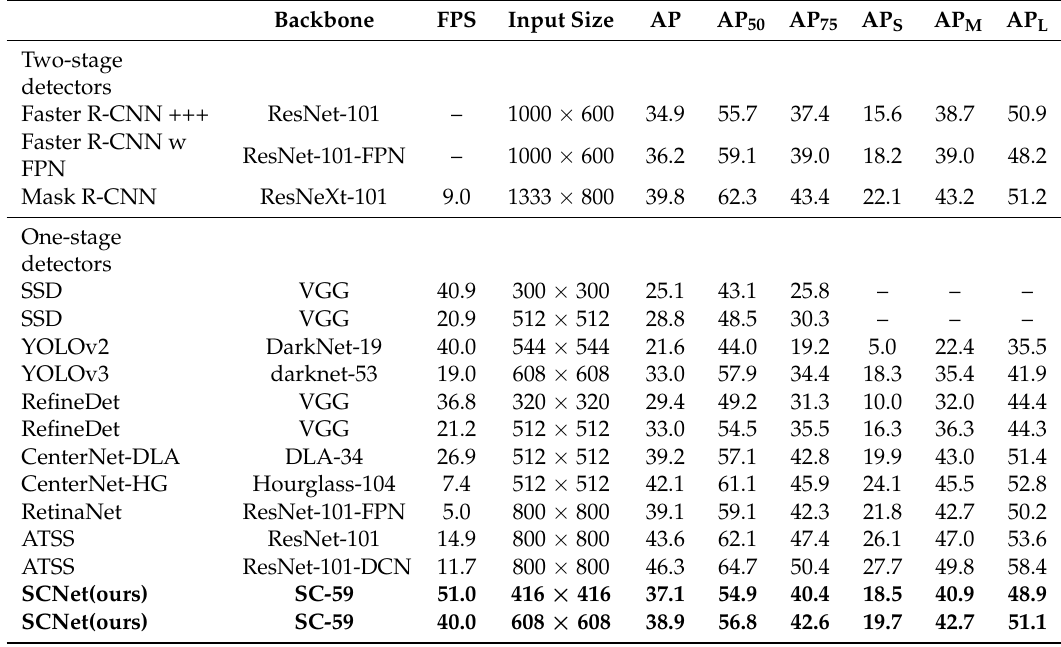
Table 4. Detection performance tested on COCO test-dev. The following table summarizes some two-stage detectors and one-stage detectors. The FPS of all mentioned detectors are measured on RTX 2080ti GPU, and the performance measure data are copied from the original publication. Our SCNet is in